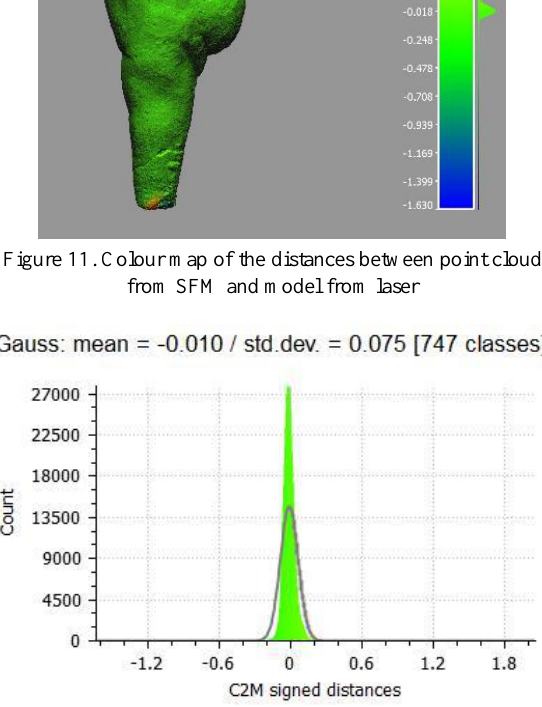
Figure 12. Gauss distribution of the